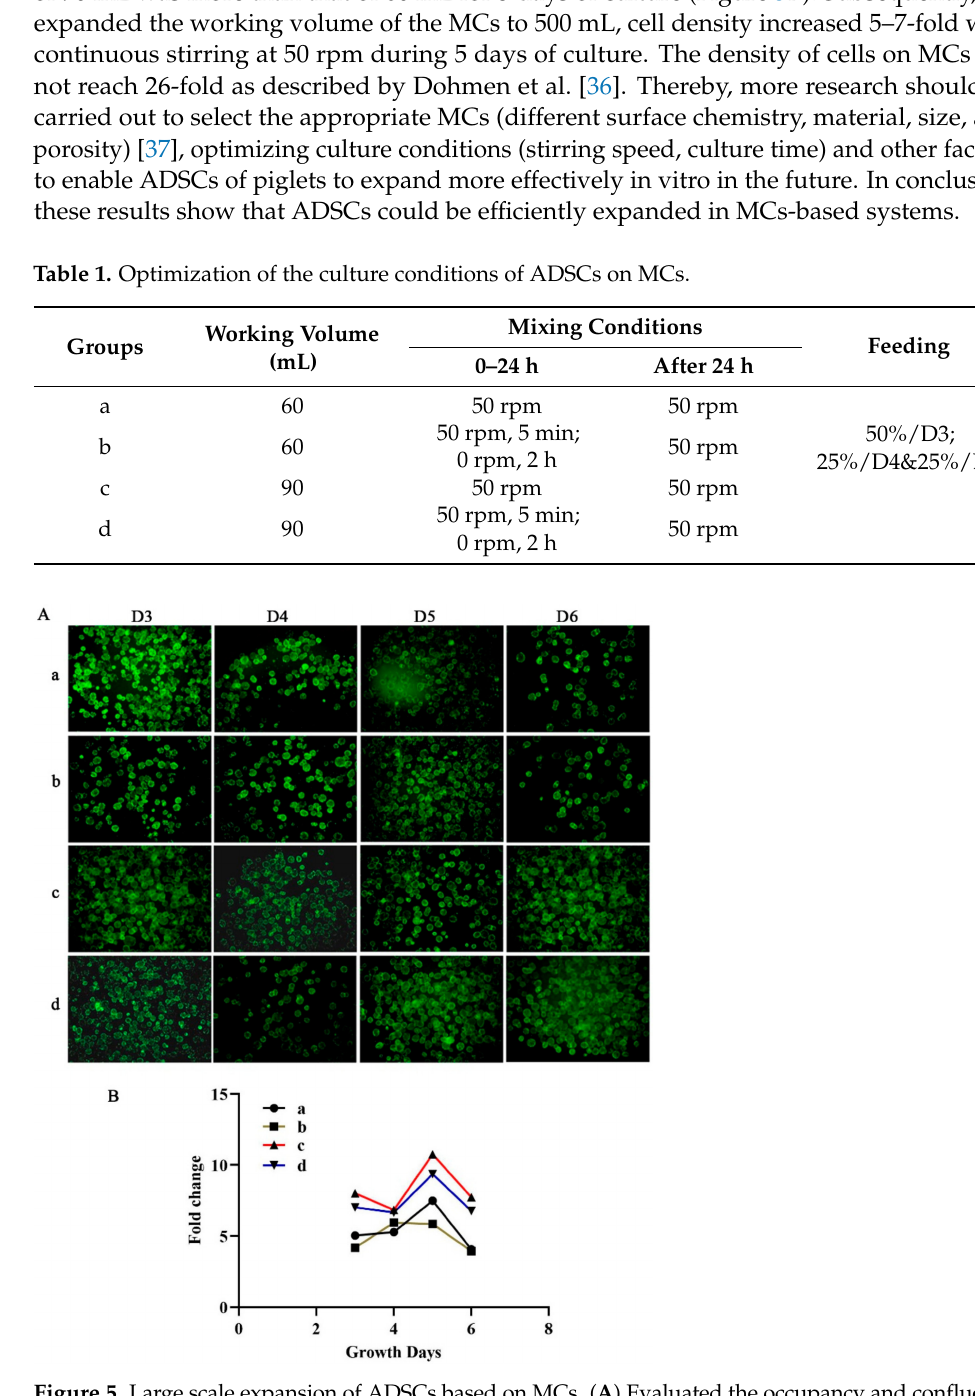
Figure 5. Large scale expansion of ADSCs based on MCs. ( A ) Evaluated the occupancy and confluency of live ADSCs on MCs stained by live/dead staining. ( B ) Fold change of ADSCs cultured on